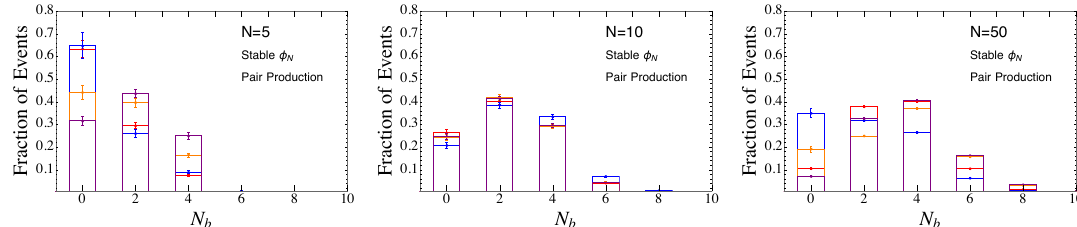
-symmetric scenario, where a SM = a = 0 2